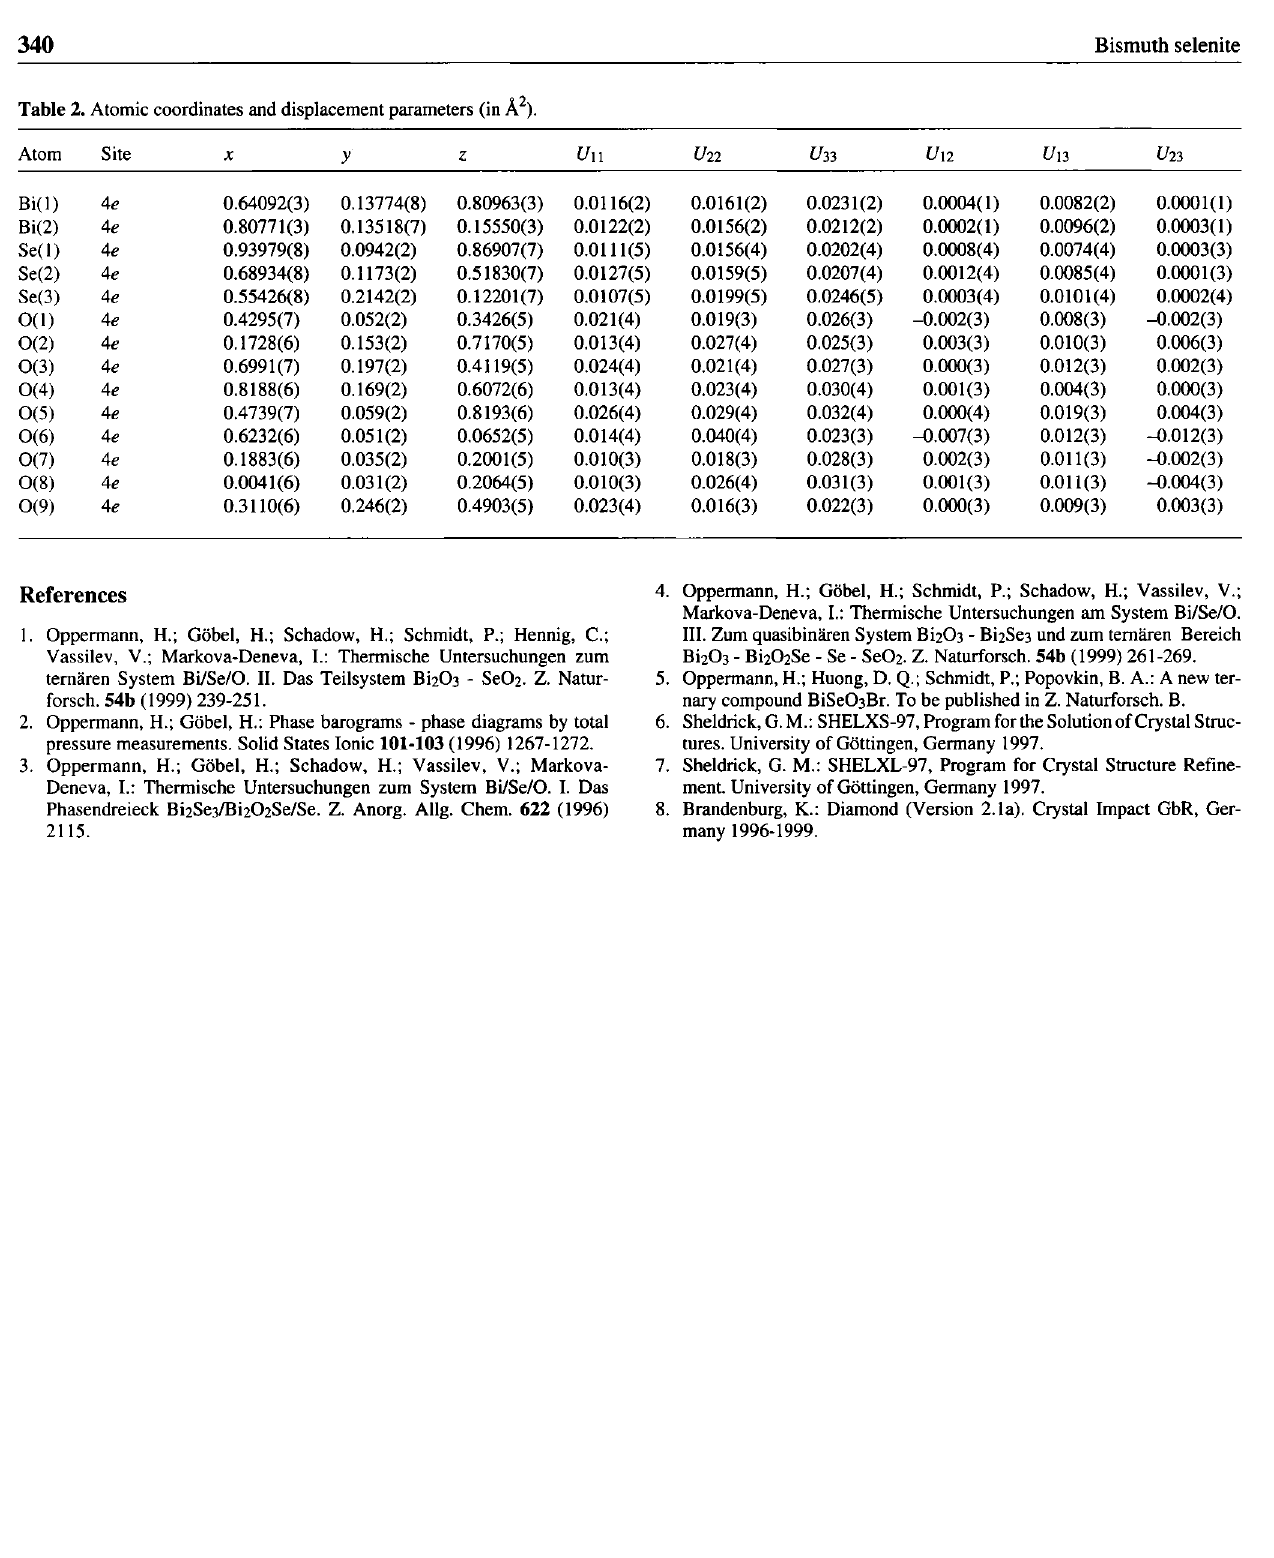
Table 2. Atomic coordinates and displacement parameters (in Ä 2